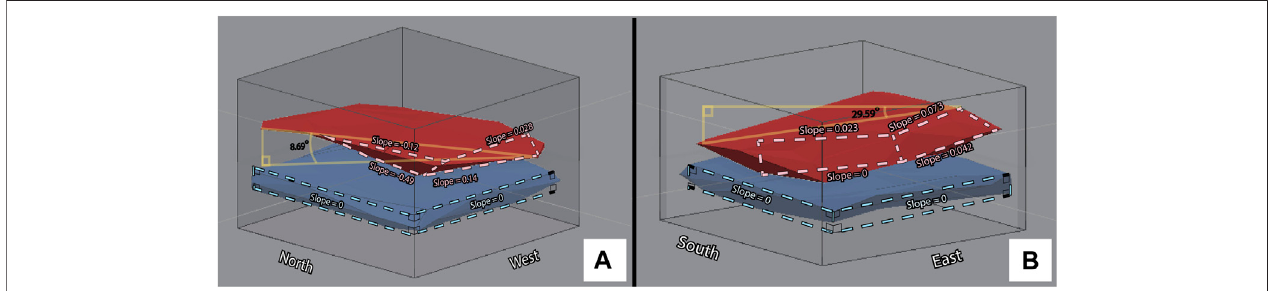
FIGURE 6 | 3D representations of the MFL (red) and oyster layer (blue) shown as concave hulls in opposing oblique views. The MFL is represented by the bone + wood intersection hull overlapped with the Cucullaea fossils from two standard deviations above and one below their mean height. The oyster layer is represented by oysters from the stratigraphic interval identi fi ed as having the most neighbors within a 1 cm radius of any other given oyster in that interval. (A) Northwest view. (B) Southeast view. The top and baselinesof the areas circumscribed bydashed lineswere used for calculating slope values for each fossil layer, which are annotated alongeachcorrespondingmargin.Righttrianglesshowninyellowwereusedtocalculatemaximumdipangles(writteninblacktext)betweenspecimensoccurringalong the base of the MFL (A) and top of the MFL (B) .